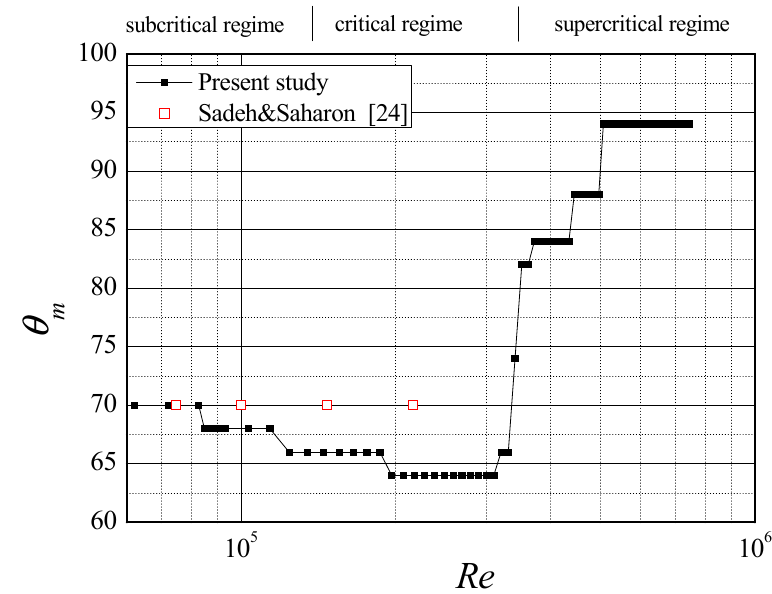
Figure 7 . The angular position of minimum wind pressure coefficient θ m in the smooth flow.